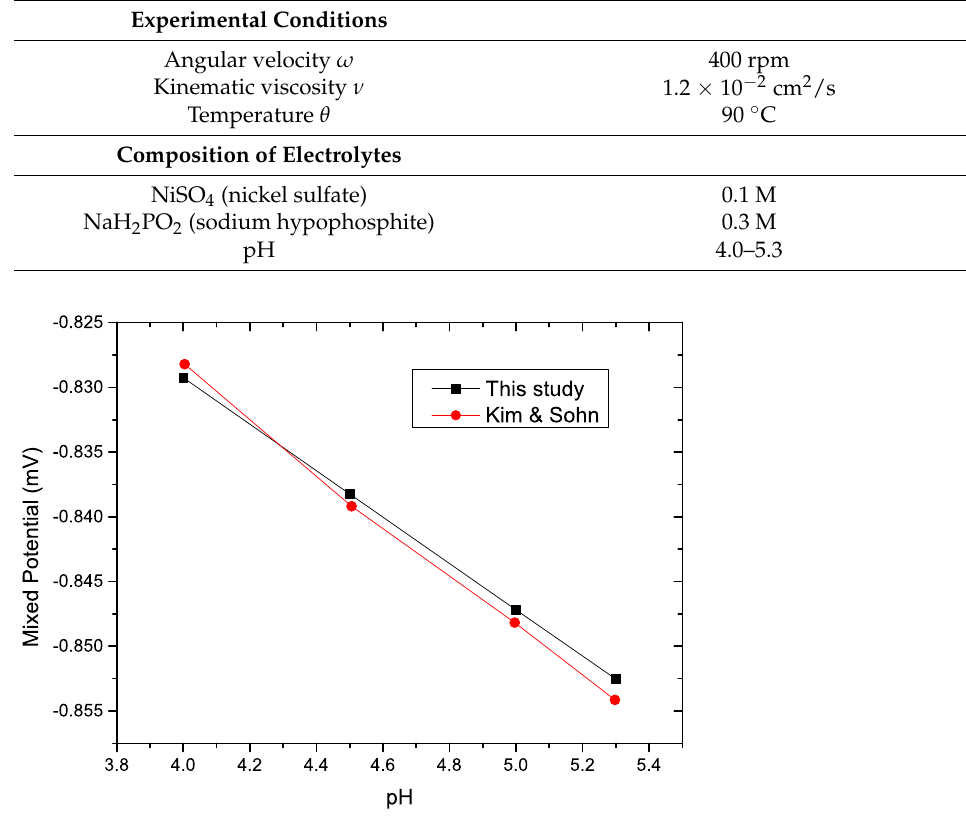
Figure 6. In red, the mixed potential E mix computed by the one dimensional system (65) versus pH = log c 04 . In black, the same but computed with the full two dimensional